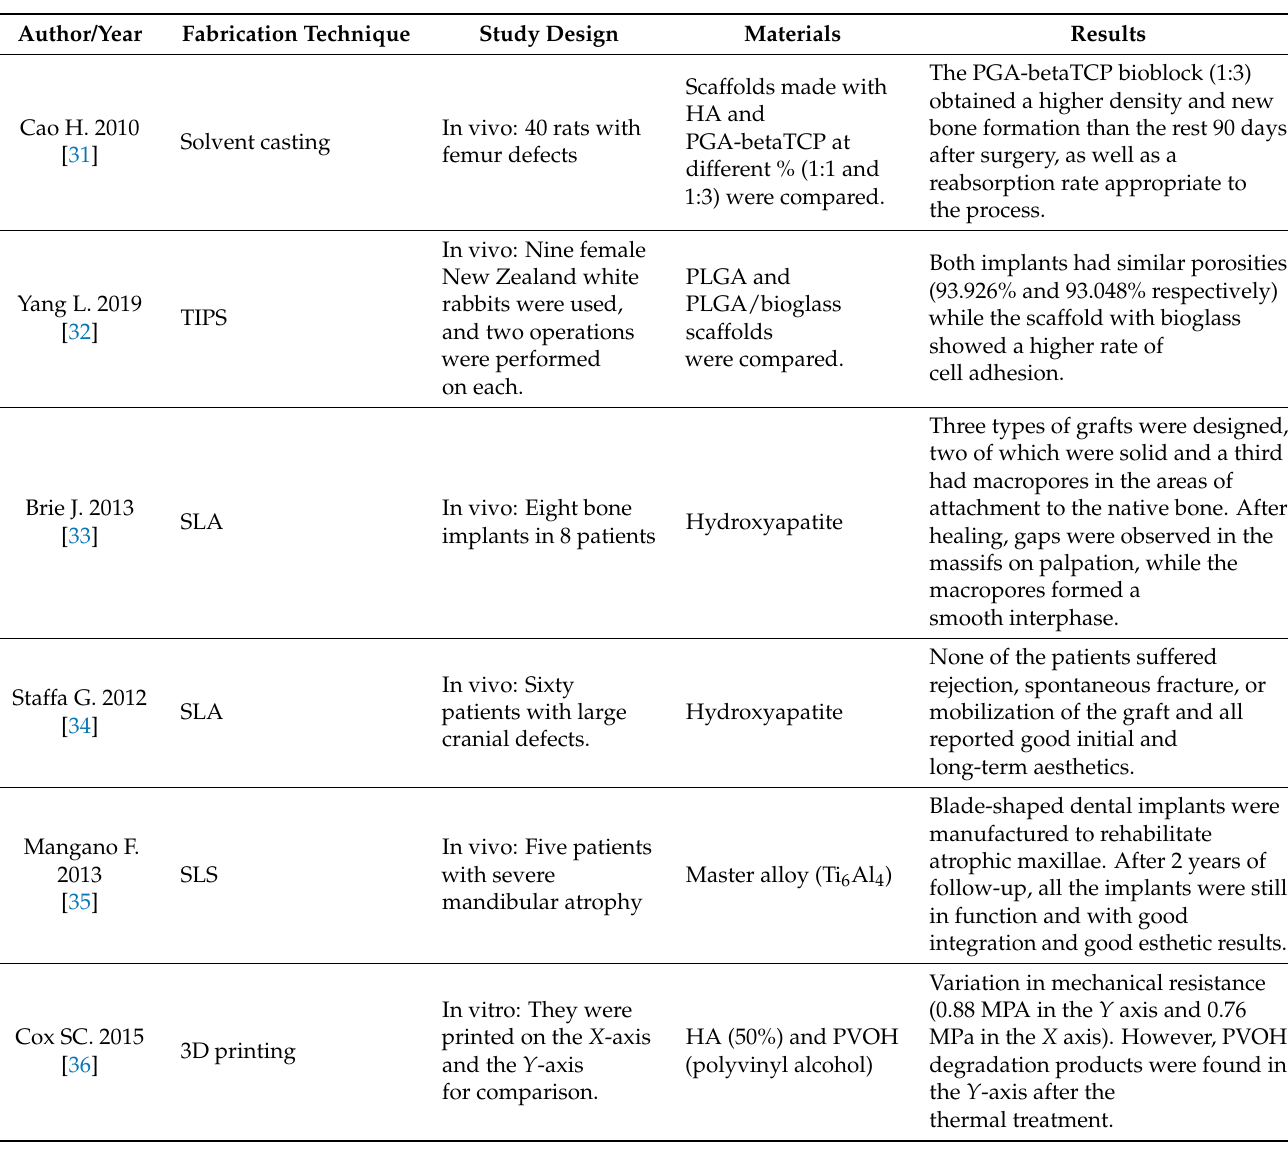
Table 2. Description of the 22 main research works found after the bibliographic search that, both in vitro and in vivo, evaluate the regenerative efficacy and the mechanical properties of scaffolds obtained with different fabrication techniques